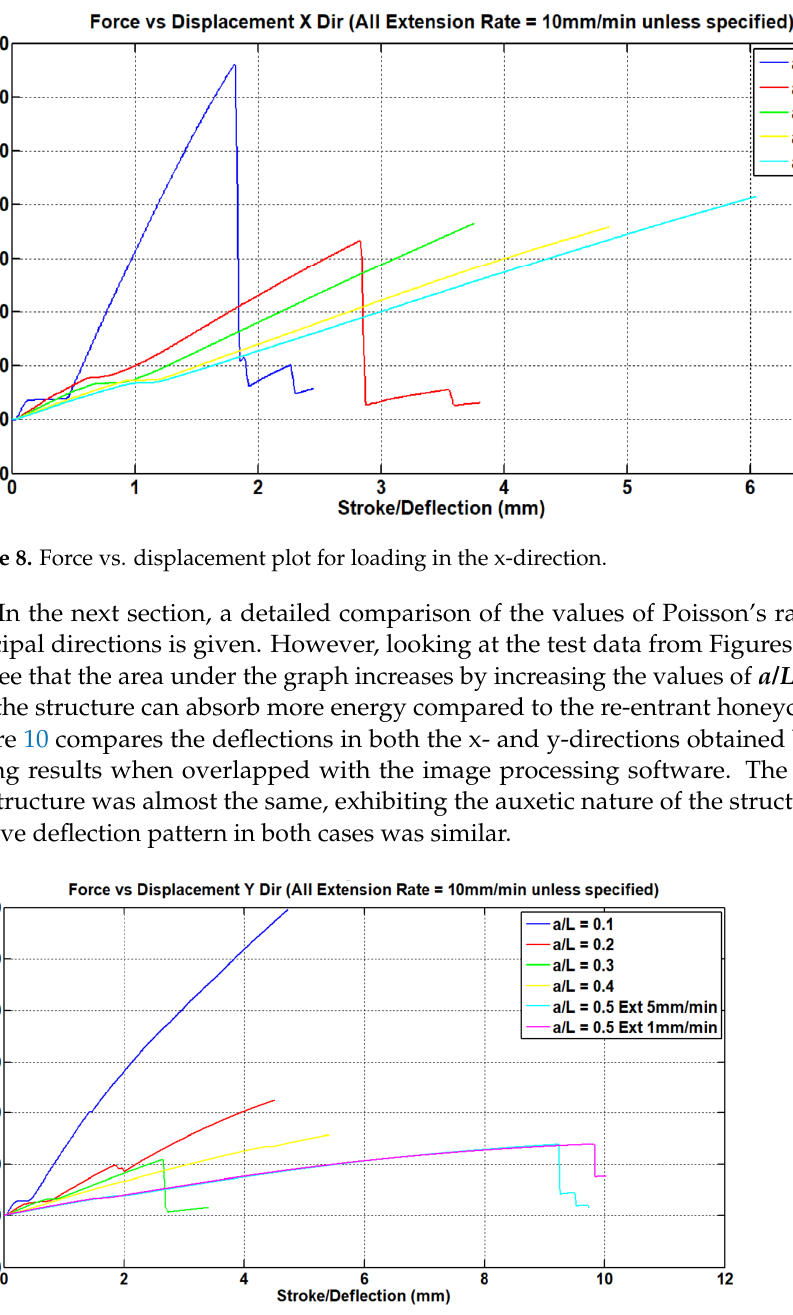
Figure 9. Force vs. displacement plot for loading in the y-direction.